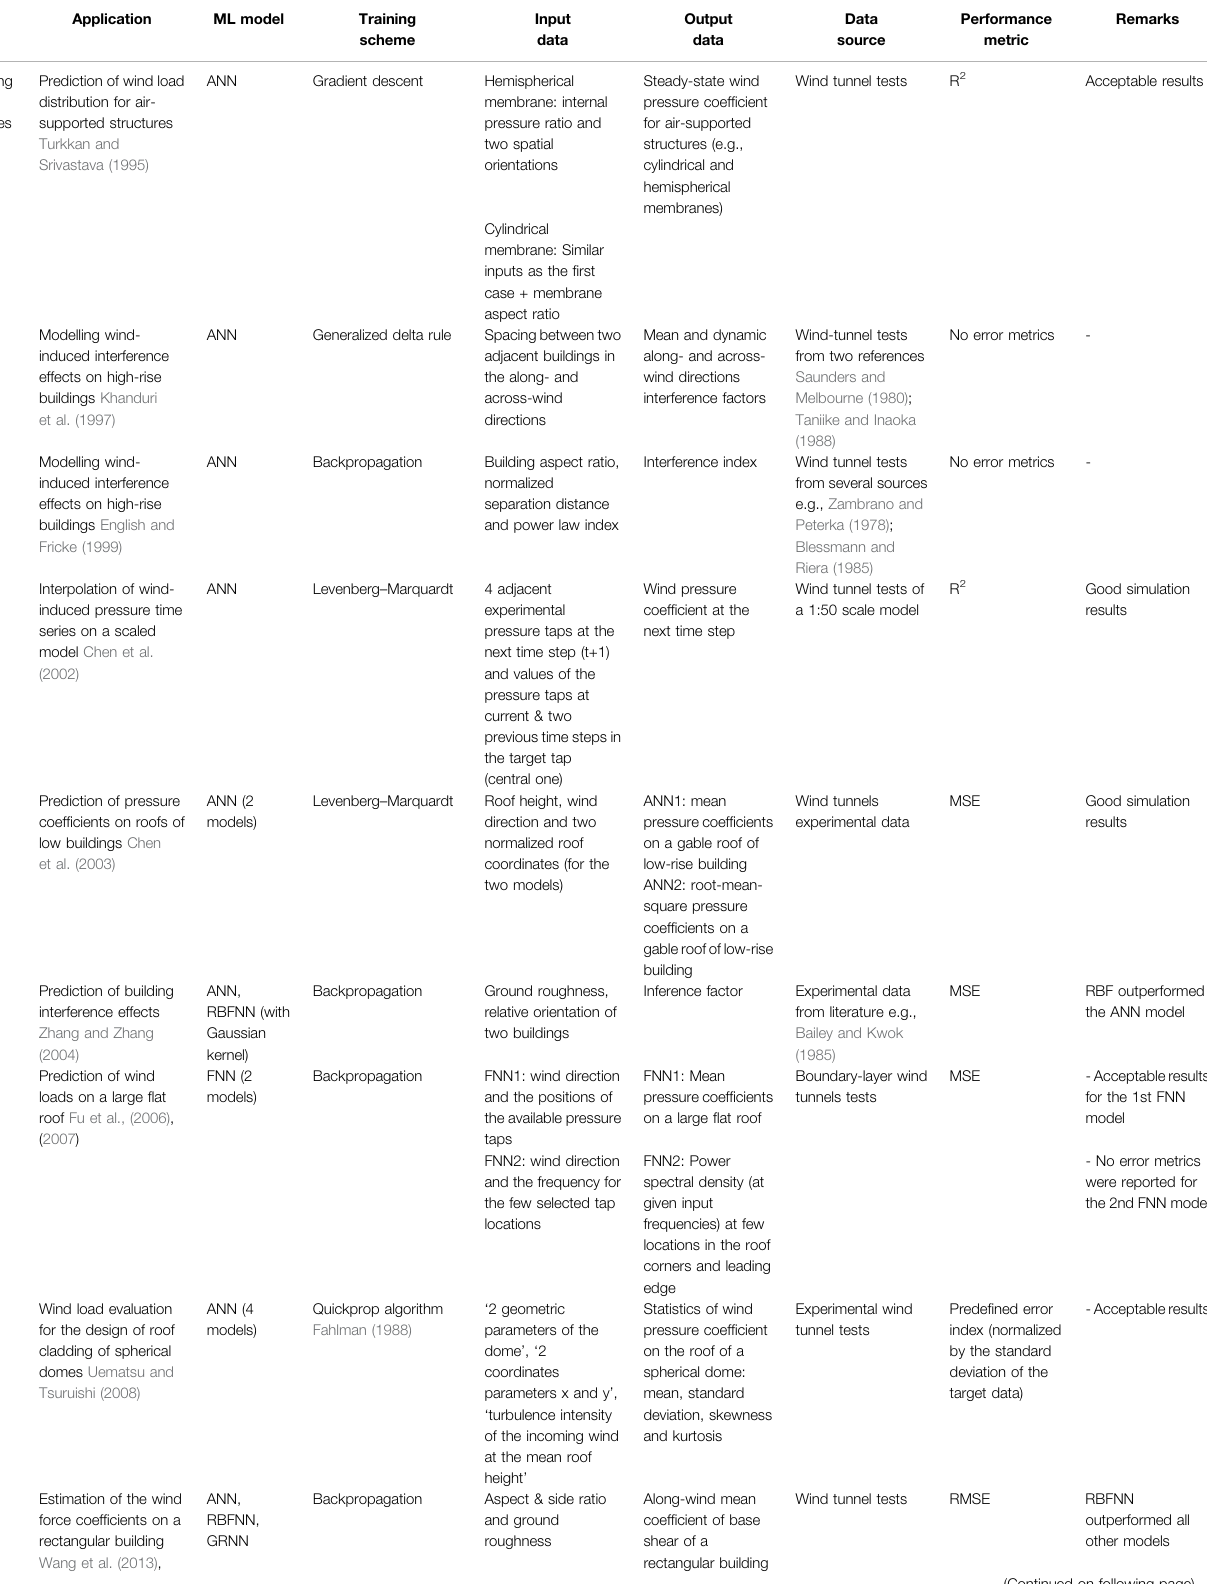
TABLE 5 | ( Continued ) Summary of ML applications for aerodynamics and